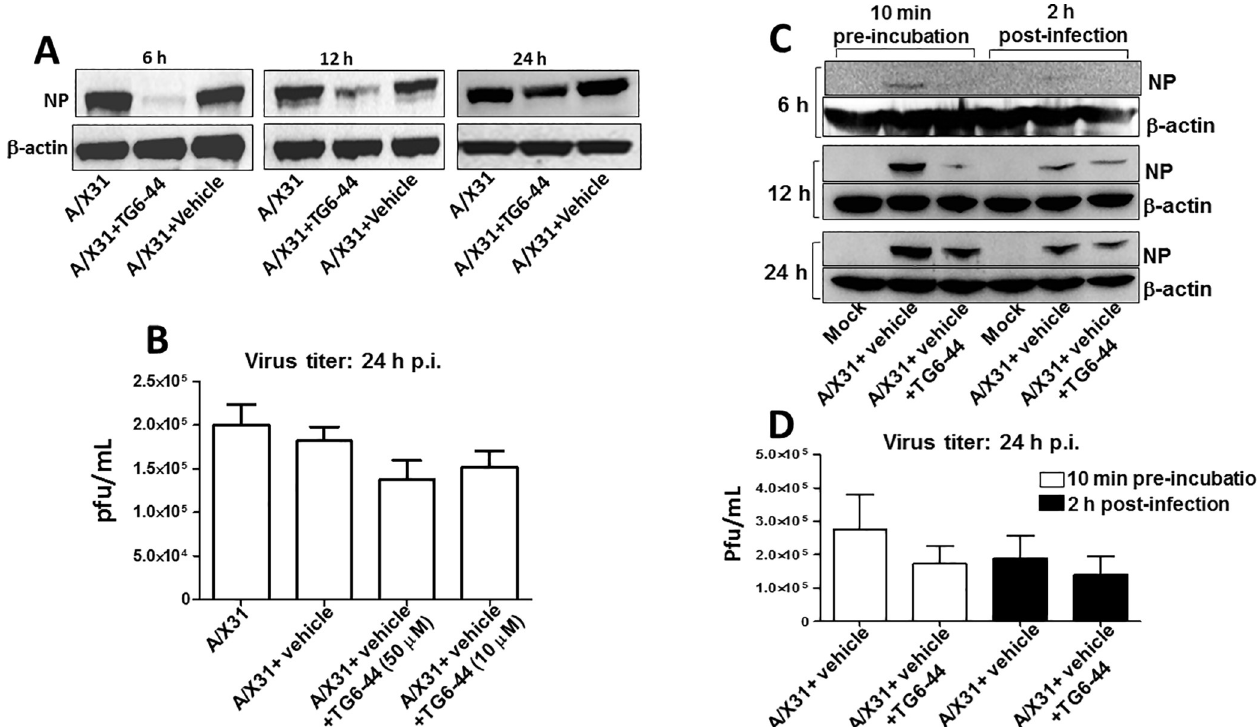
Fig 4. TG6-44 treatment changes kinetics of virus infectivity in THP-1 cells. (A) and (C); Cell lysates prepared from A/X31-infected cells treated with either vehicle or TG6-44 (50 μ M) were analyzed for NP protein expression and β -actin, by western blot assay, at 6, 12, and 24 h p.i., as described in Materials and Methods. Data represent results from one of three independent experiments. (B) and (D); Cell culture supernatants from A/X31-infected cells treated with vehicle and/or TG6-44 (10 or 50 μ m) were analyzed for virus titer at 24 h p.i by plaque assay, as described in Materials and Methods. Values in panel (B) and (D) represent mean ± SEM from three independent